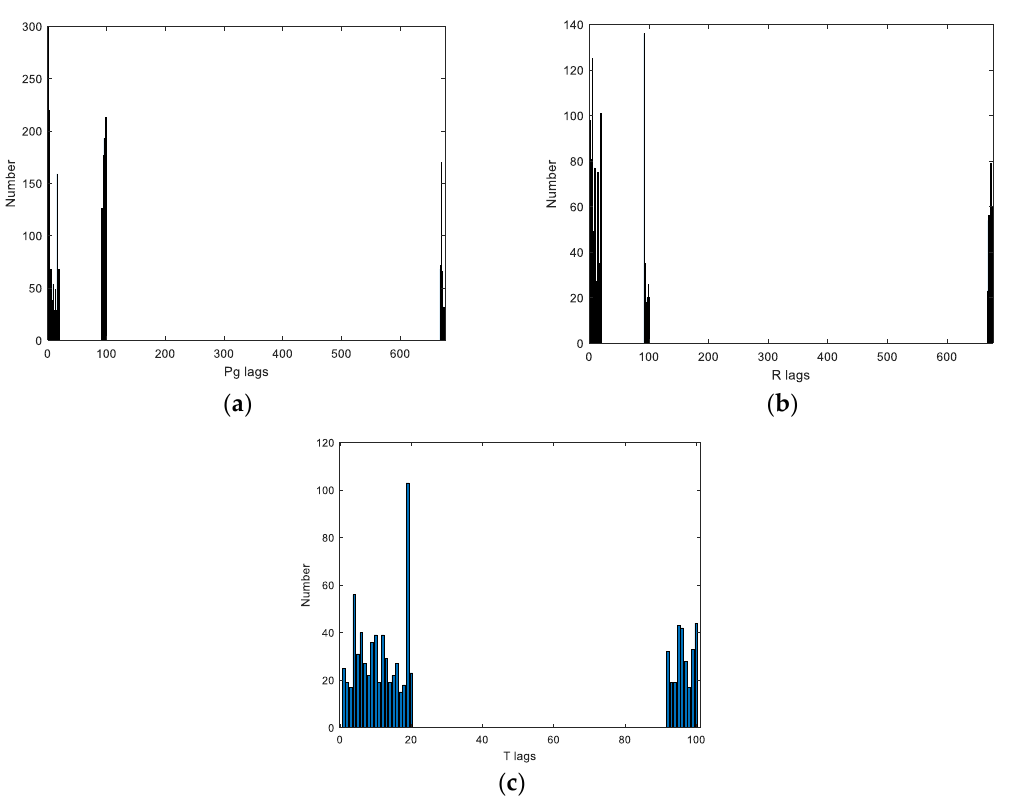
4 models: ( a ) P G ; ( b ) R ; ( c ) T .